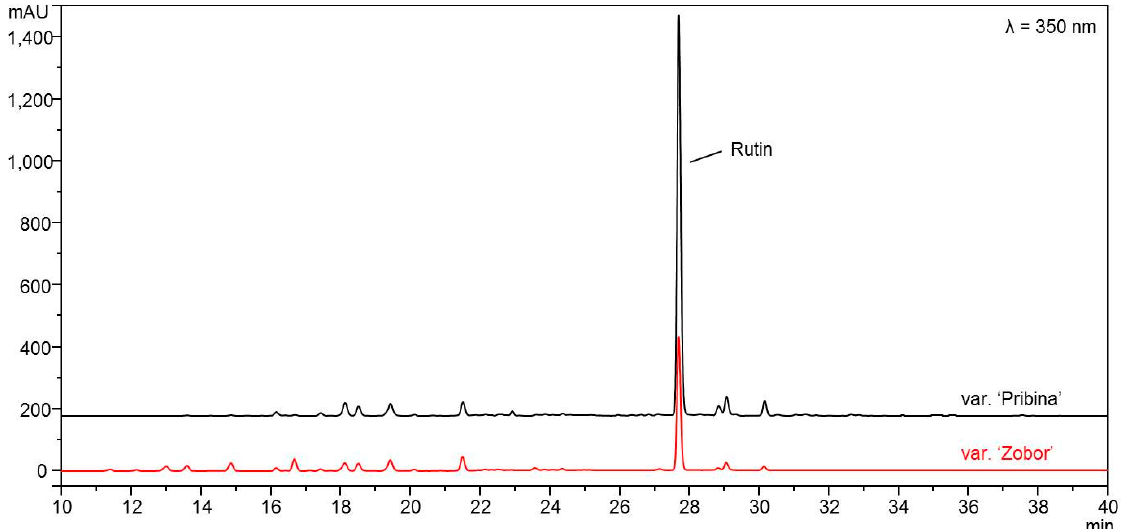
Data represent the mean ± s.d. (standard deviation); a, b values showed differences between ex-